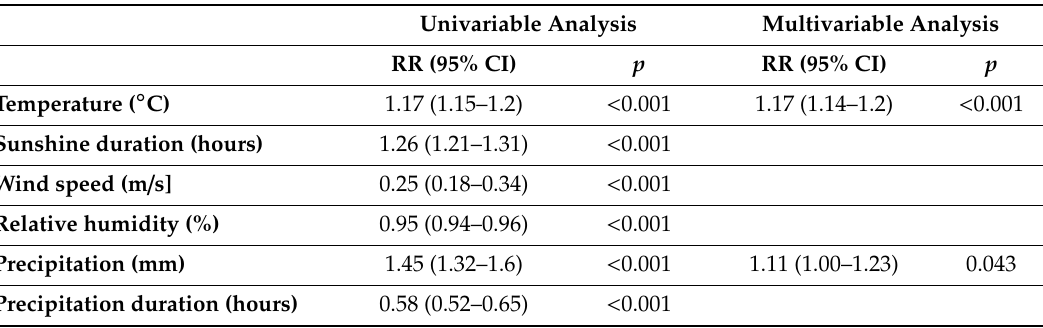
Table 3. Predictive factors of the number of cases of pediatric enteroviral infections of the CNS by uni- and multivariable generalized linear mixed models (GLMM). The coefficient of determination (R 2 ) of the multivariable model was 49.4%.